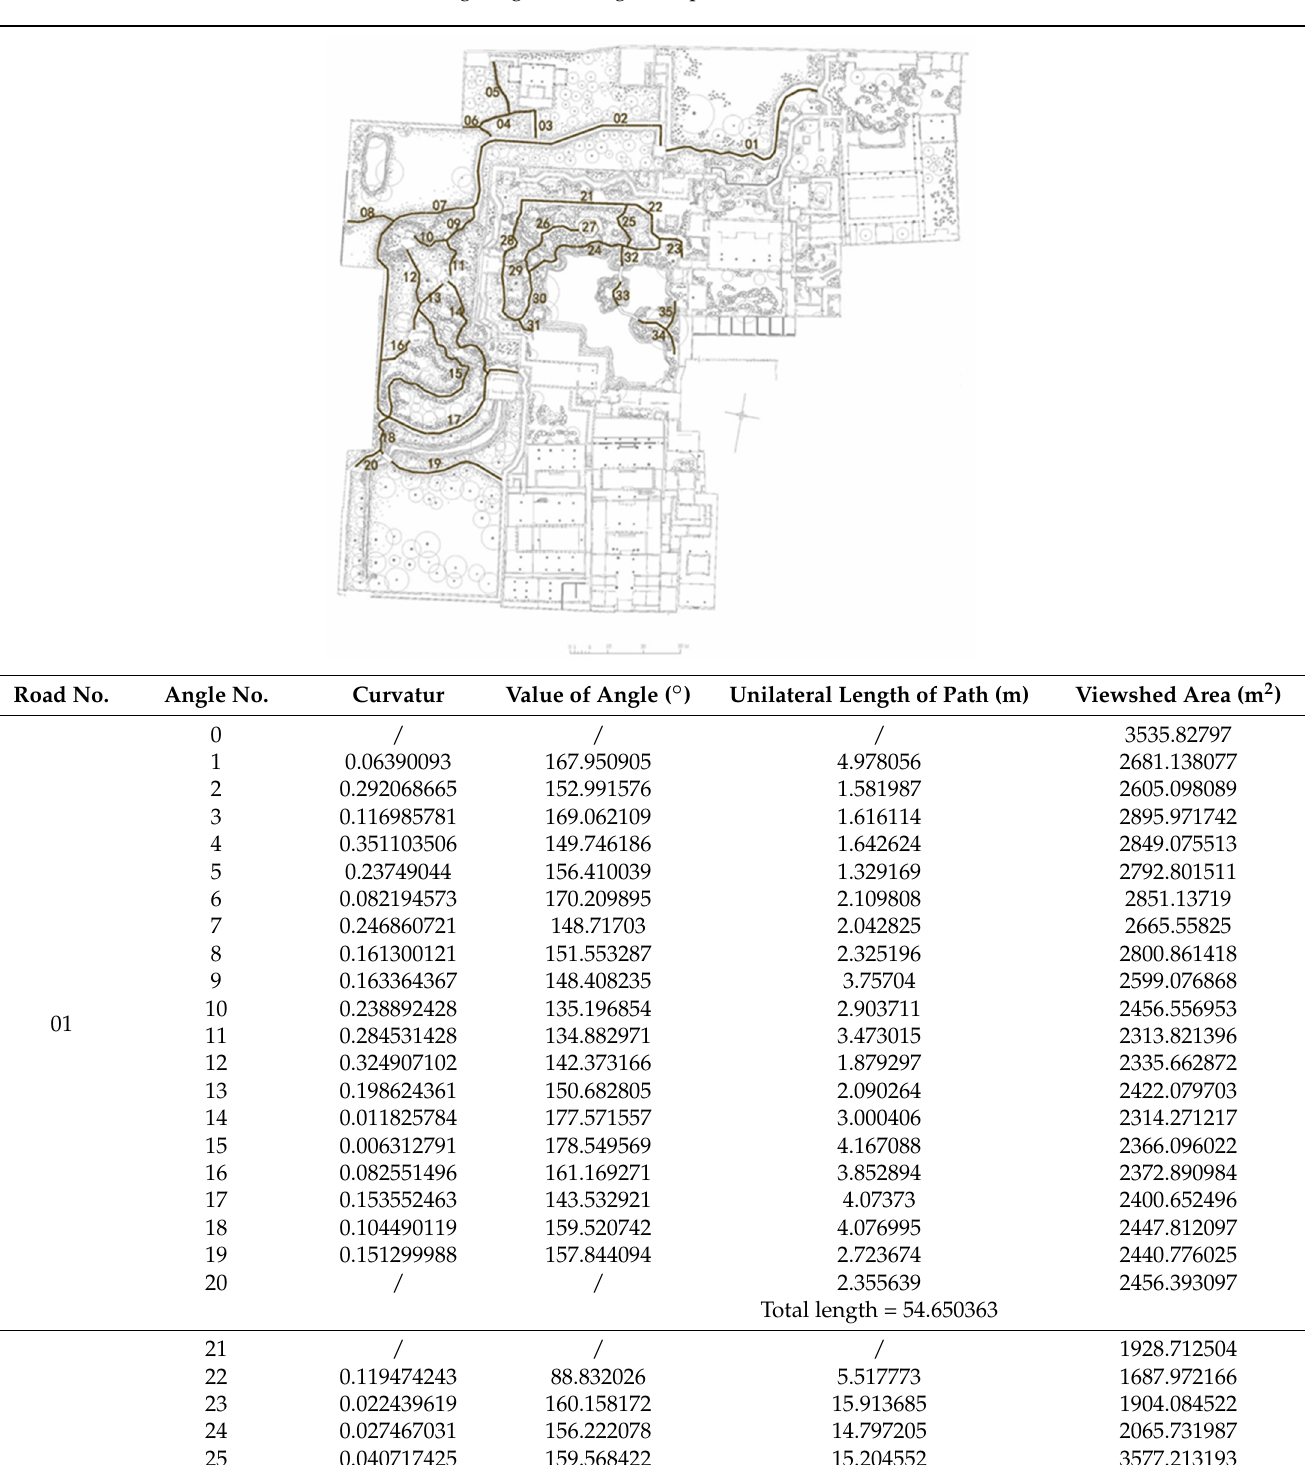
Table A3. Lingering Garden, garden path.